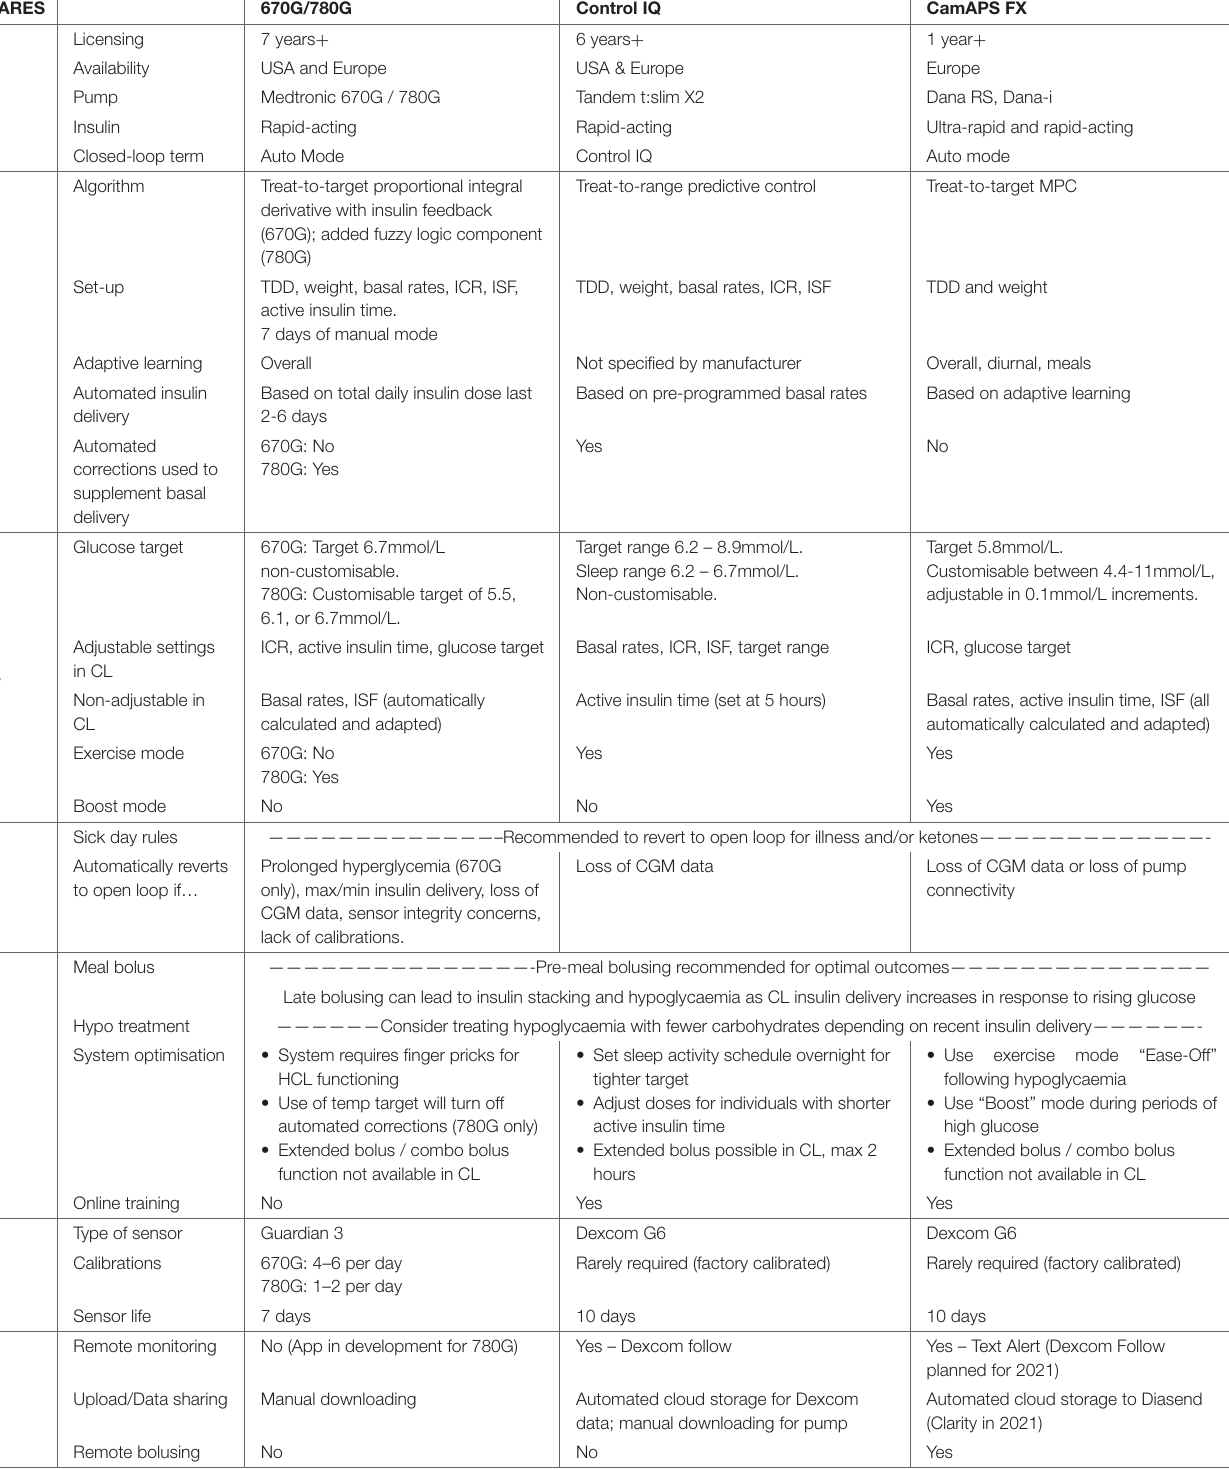
TABLE 2 | Comparison of commercially available closed-loop systems using the CARES paradigm (32). CARES 670G/780G Control